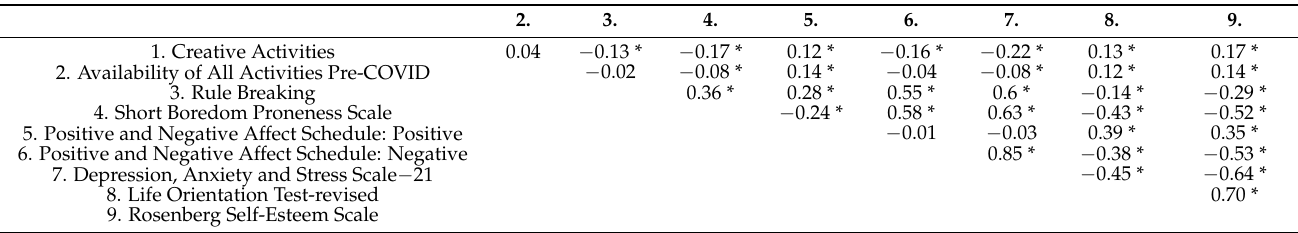
Table 2. Correlation matrix for all study